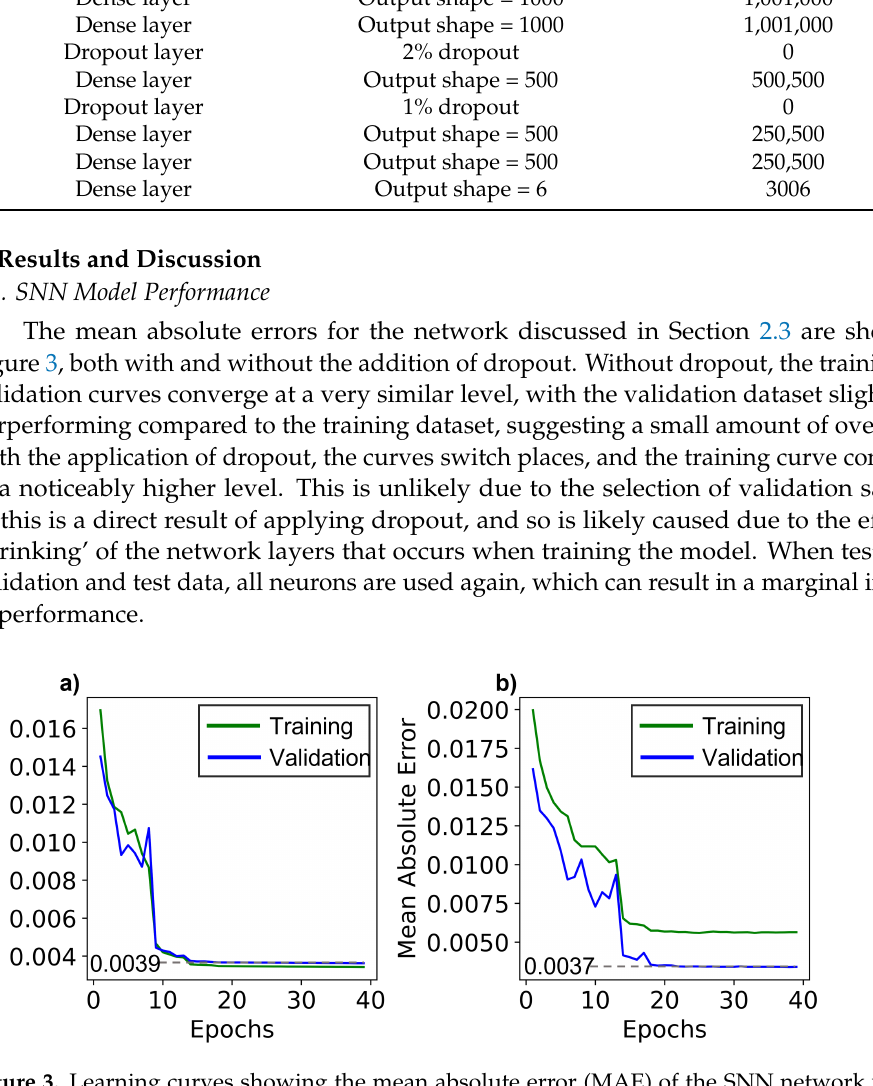
Figure 3. Learning curves showing the mean absolute error (MAE) of the SNN network without ( a ) and with ( b ) the use of dropout. Curves representing both the training and validation datasets are shown, and the final MAE of the validation curves